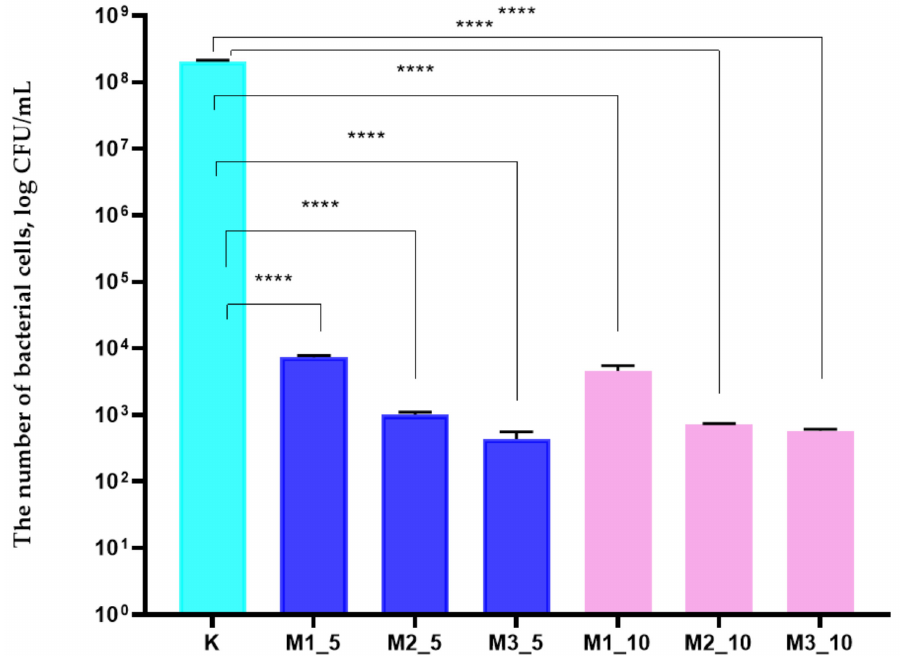
Figure 1. The influence of mixtures of S. baicalensis and Glycyrrhiza L. extracts on the viability of P